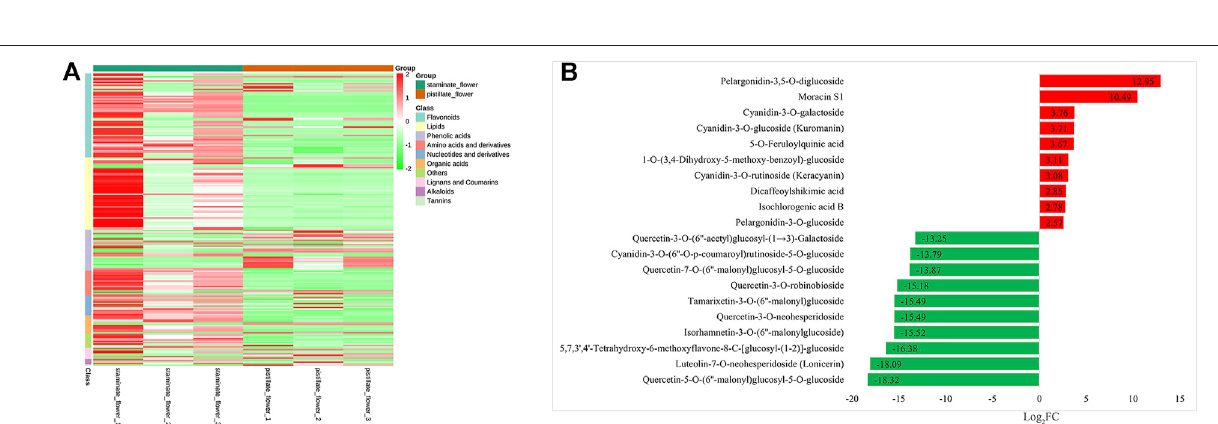
FIGURE 5 | DEMs between the SFs and PFs of mulberry. (A) Heatmap of DEMs between the SFs and PFs of mulberry. The colors from green to red indicate the relativecontentsofmetabolites inthe SFscompared withthosein thePFs. (B) Barchart oftop 10DEMs ofSFs and PFs, respectively. Red and greenbars on theY-axis represent up-expressed and down-expressed metabolites in SFs,